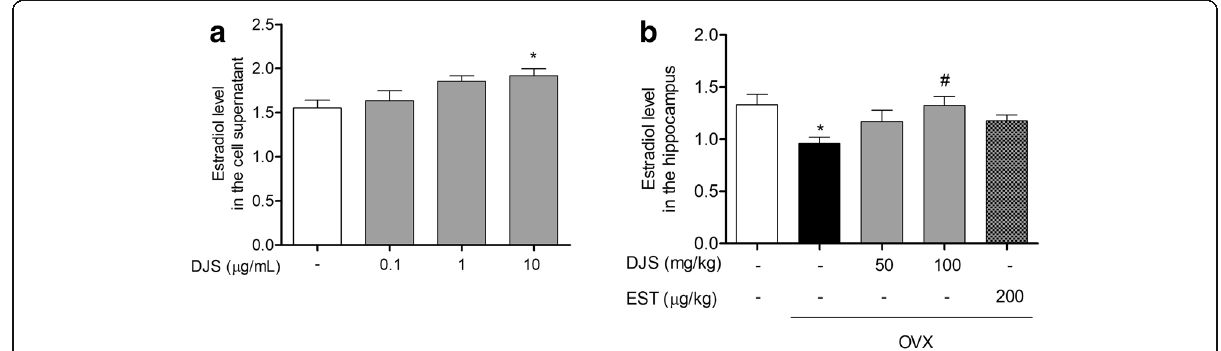
Fig. 1 Effects of DJS on hippocampal estrogen synthesis in primary hippocampal cells and hippocampus of OVX mice. Rat primary hippocampal cells were treated with the DJS for 48 h. Female mice were administrated with DJS at the concentration of 50 and 100 mg/kg/day and EST at 200 μ g/kg/day for 21 days after OVX surgery. Then, EST levels in the supernatant of cell culture ( a ) and hippocampus ( b ) were measured by ELISA. Values are means ± standard error. * p < 0.05 compared with the sham group, # p < 0.05 compared with the OVX